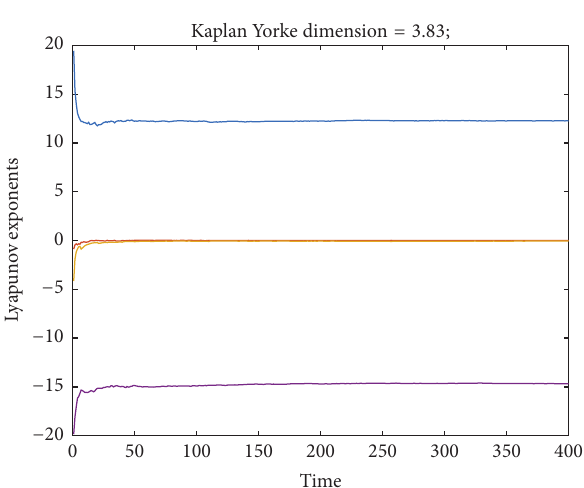
Figure 18: Evolution of the Lyapunov exponents values versus the integration